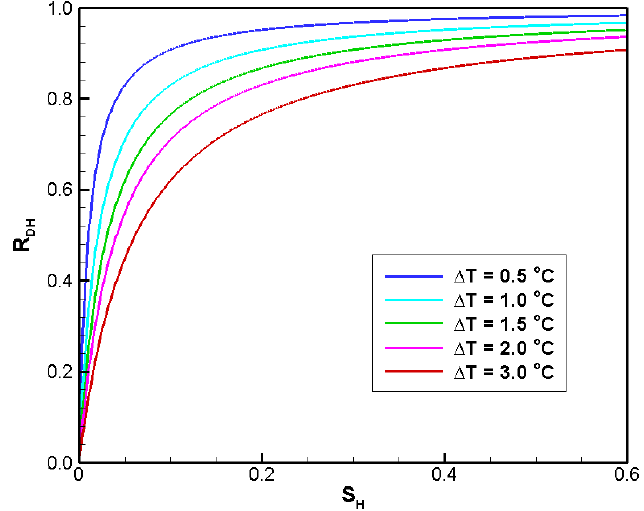
Figure 4. Dependence of energy efficiency of hydrate exploitation by heat stimulation R on hydrate saturation S , and sensitivity to temperature difference Δ H